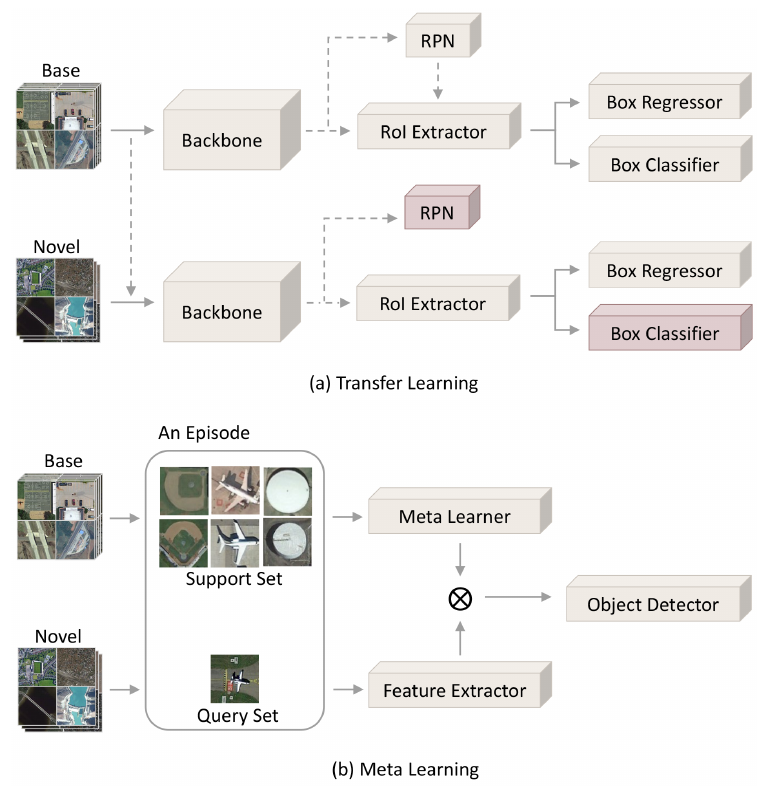
Figure 4. The illustration of two branches of few-shot object detection, transfer learning ( a ) and meta learning ( b ). Transfer learning follows standard supervised learning. The upper pipeline is the base training phase, while the lower pipeline is the few-shot fine-tuning phase. Meta learning episode setting is determined by novel classes. ⊗ means semantic fusion operation, such as deep- wise cross-correlation.